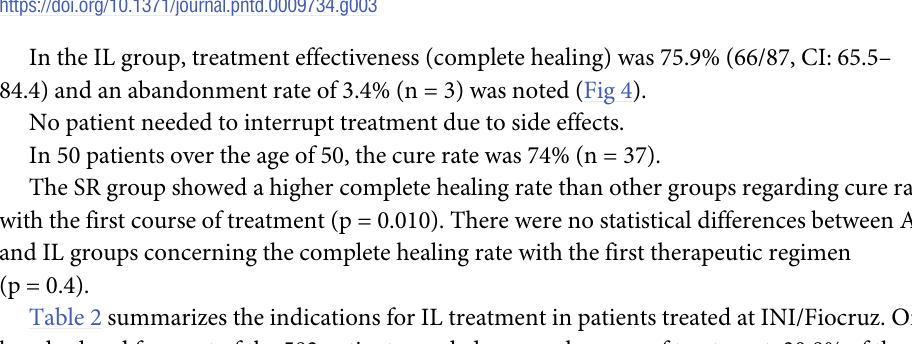
Fig 3. Patients follow-up: alternative regimen group. AR- alternative regimen; SR-standard regimen; IL- intralesional route; AE- adverse events.